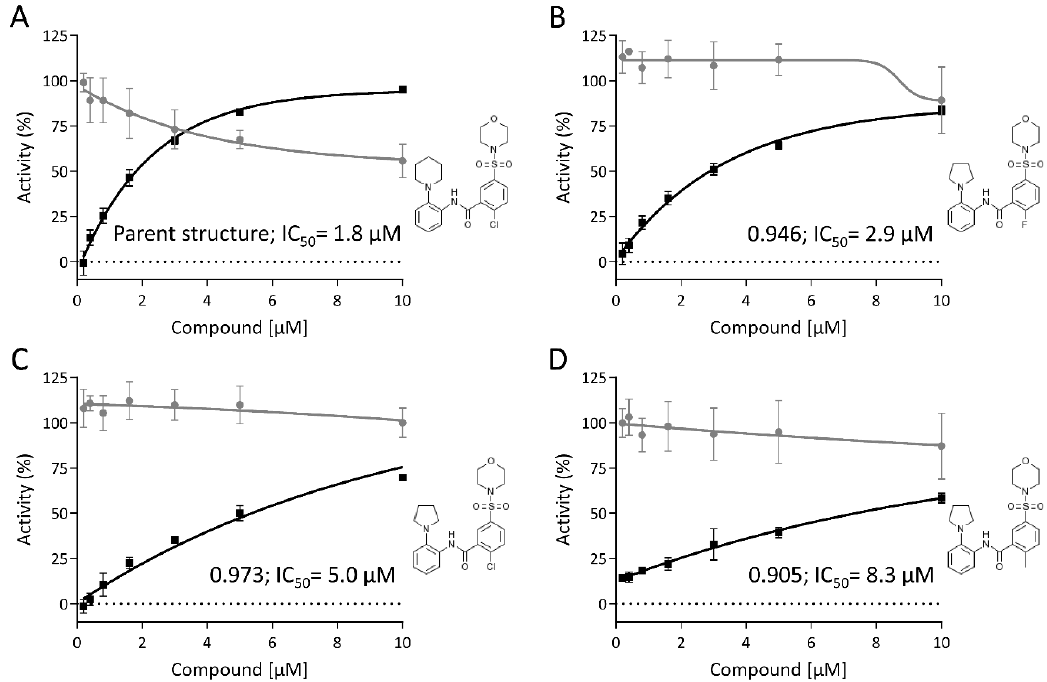
Figure 6. Example of four similar inhibitors showing structure-specific di ff erences in activity ( A – D ). Cellular viability relative to the DMSO-treated control is shown in grey. Inhibition of virus integration is shown in black. The compound structures are given next to the inhibition curves. The numbers next to the curves indicate the similarity based on the tanimoto coe ffi cient and the IC 50 in the virus integration